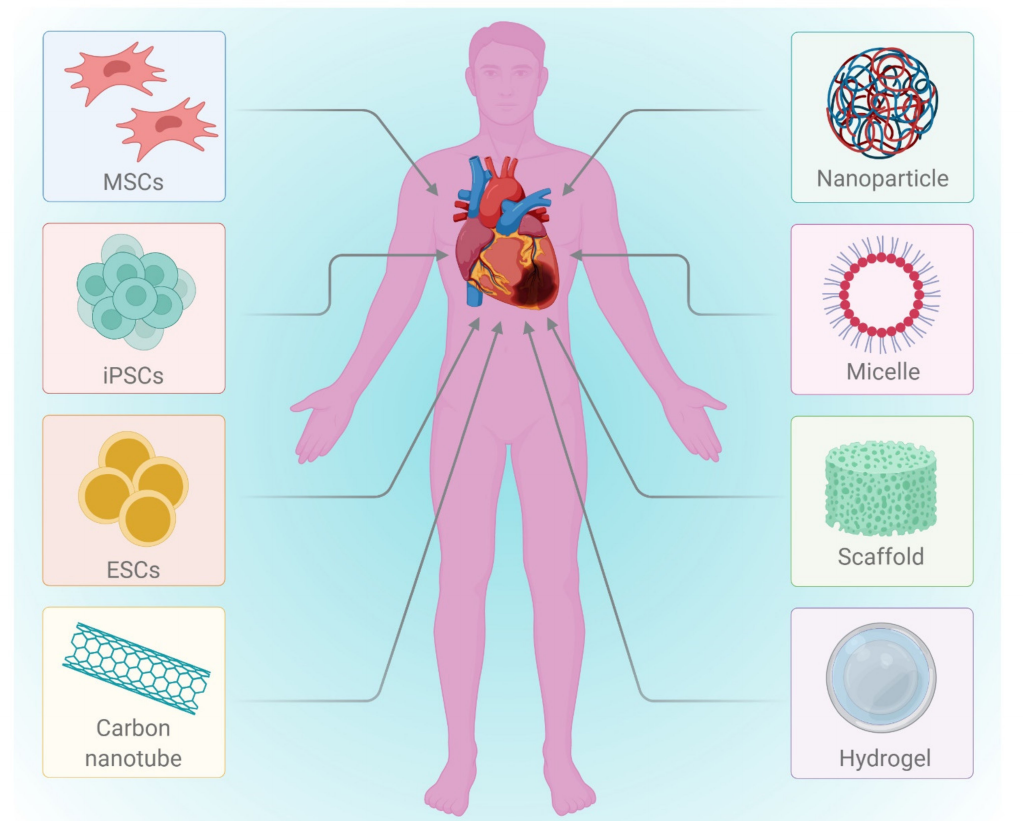
Figure 2. Illustration of stem cell-based regenerative medicine in MI treatment. Various stem cells like MSCs, ESCs, and iPSCs have been employed in MI treatment. Stem cells are delivered through engineered novel biomaterials (via encapsula- tion) that mimic the native niche. The stem cell-based regenerative therapy is beneficial to either replace the injured area or the whole